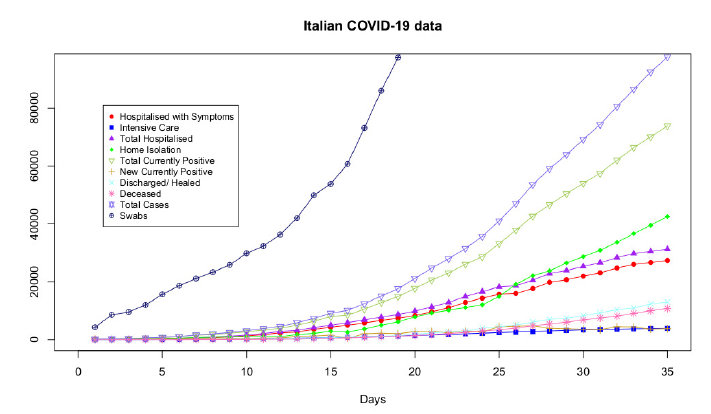
Figure 1. The trends of Hospitalized with Symptoms data, Intensive Care data, Total Hospitalized data, Home Isolation data, Total Currently Positive data, New Currently Positive data, Discharged/Healed data, Deceased data, Total Cases data, Swabs data. Day 1 is 24 February